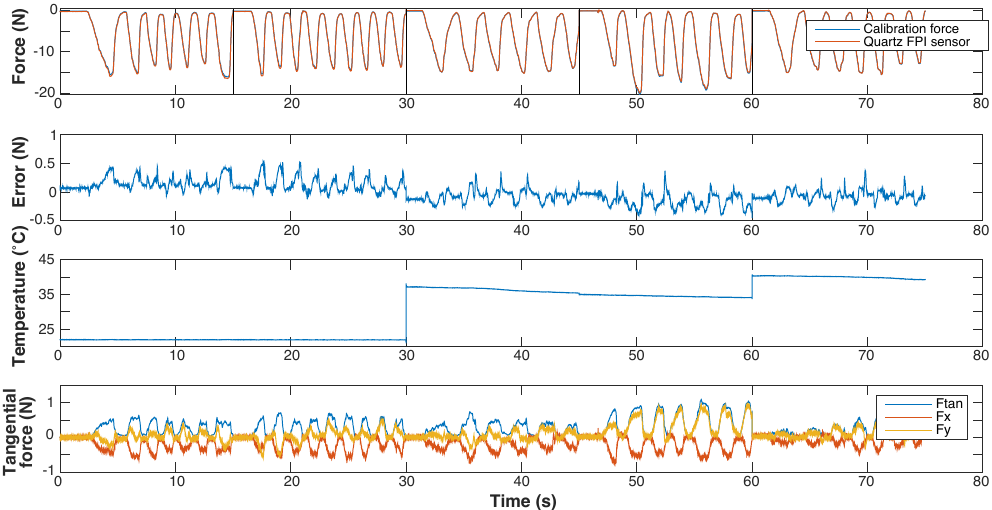
Figure 10. Results of dynamic calibration with temperatures varying between 22 °C and 40°of the prototype of the quartz capillary concept, shown as function of time. The graphs show, from top to bottom: (1) the calibration force and the force measured with the prototype, calculated using the interpolation function shown in Figure 9; (2) the measurement error of the prototype; (3) the temperature of the water bath in which the needle tip is submerged; (4) the transverse force on the needle tip, shown as the resultant transverse force (Ftan) and its two orthogonal components (Fx and Fy). The dotted lines in the top graph (1) indicate the 15 s long fragments of which the dynamic calibration dataset is